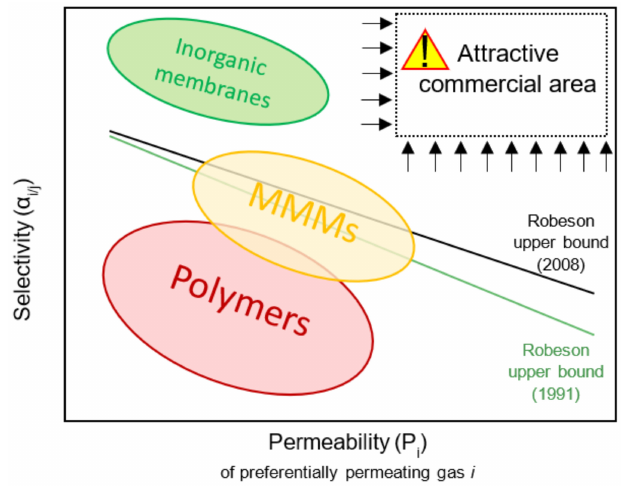
Figure 1. Relationship between permeability and selectivity. Current situation between different membrane composition regarding Robeson upper bound and the attractive commercial area. Adapted from Dechnik et al. [26].